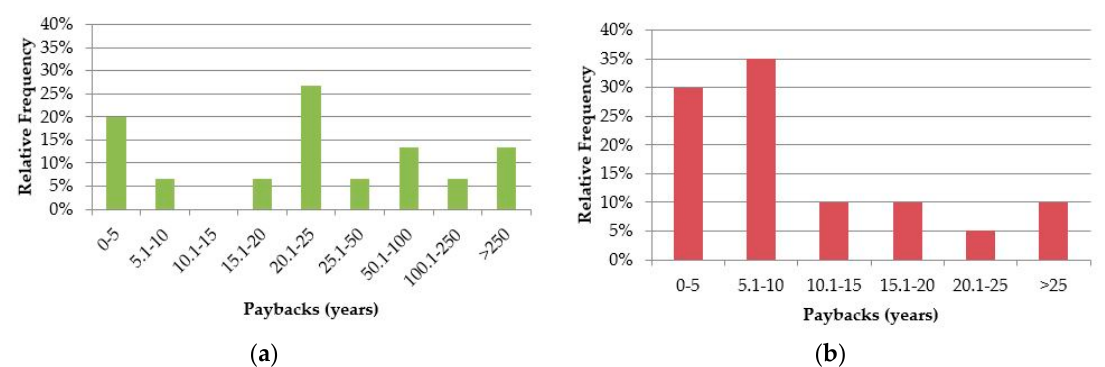
Figure 5. Percentage frequencies of the paybacks in ( a ) residential buildings and ( b ) commercial and public